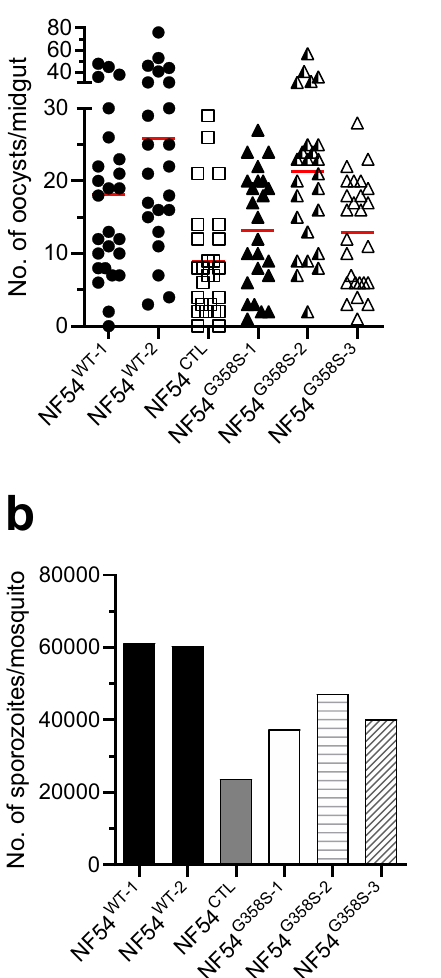
Fig. 8 | Parasites with the G358S mutation in PfATP4 are infective to mosqui- toesandproducesalivaryglandsporozoites.a LeftPanel:Oocystnumbersinthe midguts of Anopheles stephensi mosquitoes fed on gametocyte cultures of the parasite lines indicated ( n =23 – 26mosquitoes perline; determinedonDay 12 post blood meal). The red bar indicates the mean. Data for two NF54 WT cultures (pre- pared from separate vials that had been frozen on different dates; closed circles) are shown. Right Panel: Pooled data for statistical analysis. Because of the high variability inherent in these data, we pooled the two NF54 WT controls (closed cir- cles) and the three mutant lines (NF54 G358S-1 , -2 , and -3 ; closed triangles) for analysis.